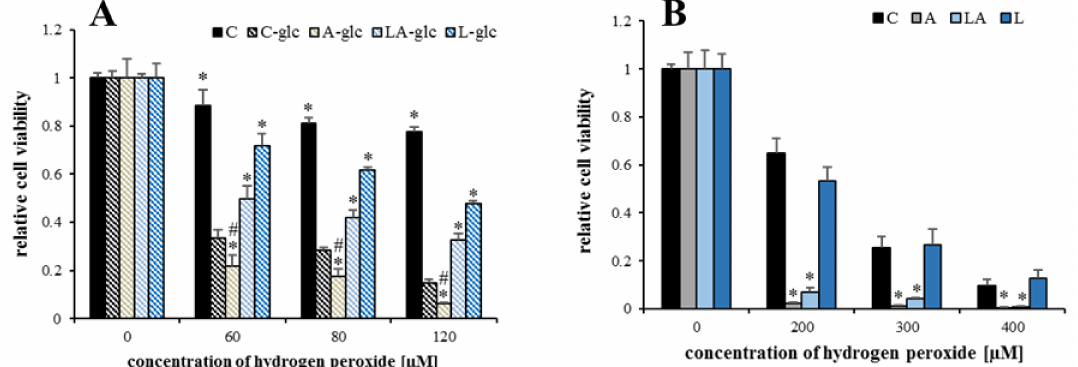
Figure 8. Synergic effects of lactic acidosis and metabolic manipulations. ( A ) The viability of PaTu-8902 cells treated with the experimental media lacking glucose for 72 h and challenged with the indicated concentrations of hydrogen peroxide. ( B ) The viability of PaTu-8902 cells was treated with experimental media and carbonyl cyanide- p -trifluoromethoxyphenylhydrazone (FCCP) for 72 h and challenged with indicated concentrations of hydrogen peroxide. Viability was measured by resazurin assay. C, control; A, acidosis; LA, lactic acidosis; L, high lactate (* p < 0.05 compared to C, # p < 0.05 when comparing A and